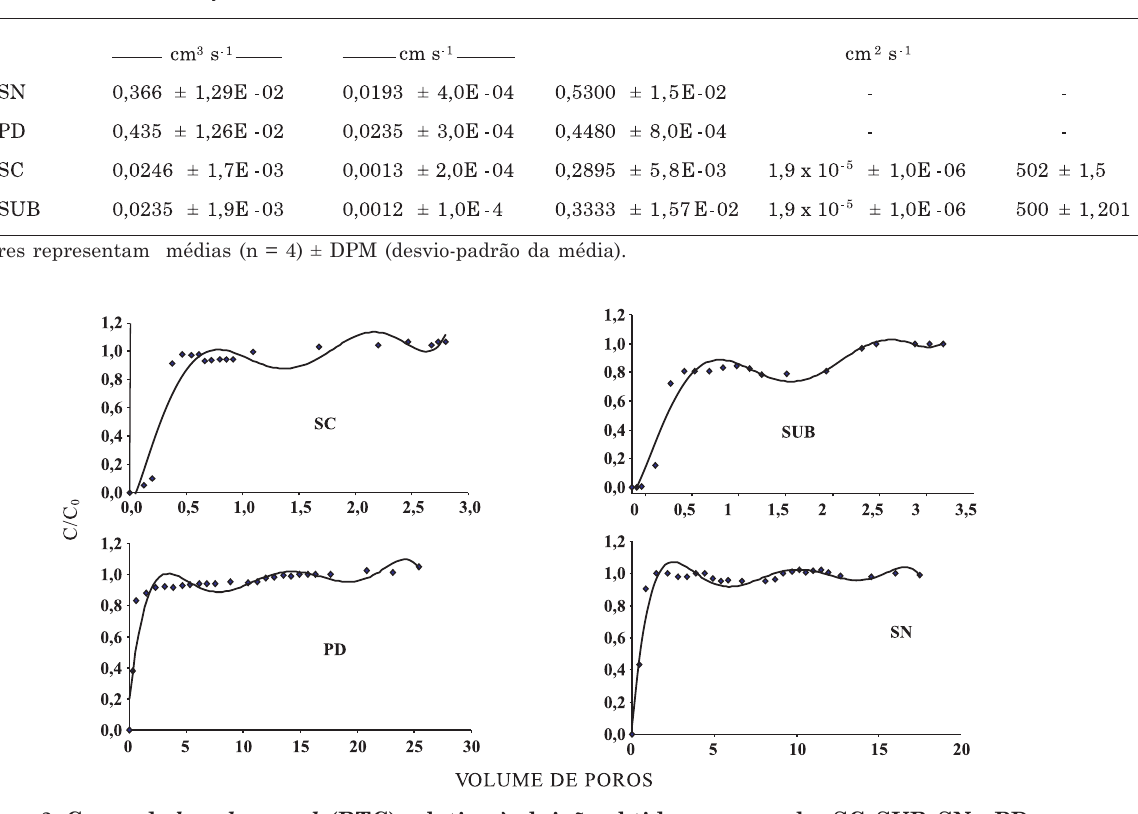
Figura 3. Curva de break-trough (BTC) relativa à eluição obtida para os solos SC, SUB, SN e